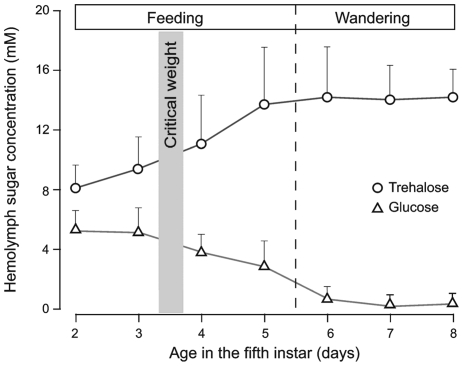
Hemolymph glucose and trehalose concentration during the last larval instar.Values are means of 10–16 individuals ±SD.